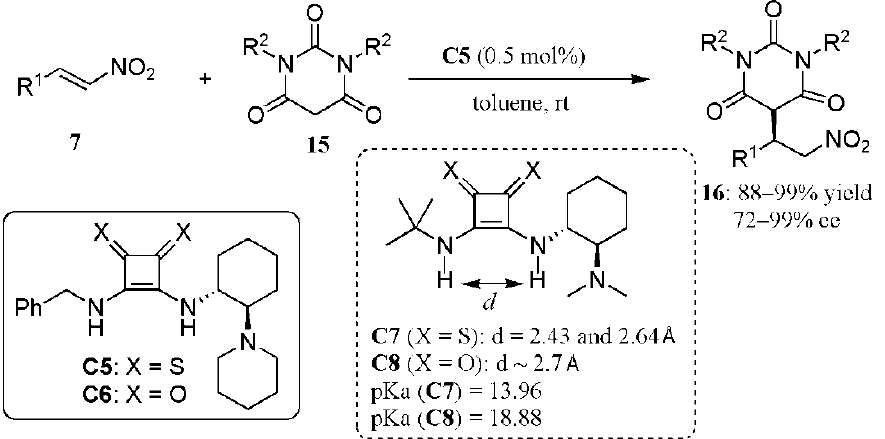
Figure 11. Enantioselective Michael additions of barbituric acids to nitroalkenes catalyzed by C5 , a novel thiosquaramide catalyst [34].